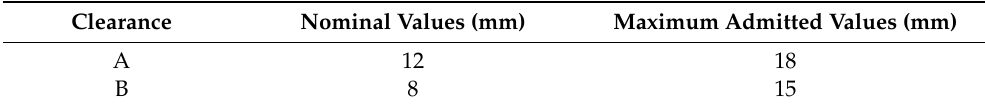
Table 11. Values of the maximum clearances of the